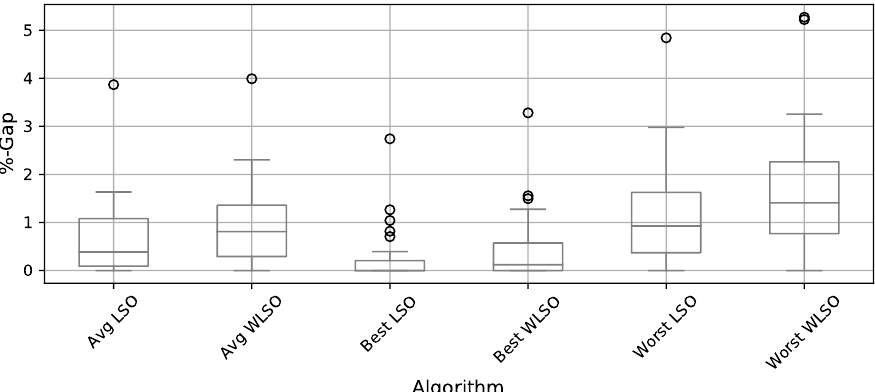
Figure 2. Average, best, and worst values box plots for 100 easy instance results of Random, Percentile, and k-means algorithms.